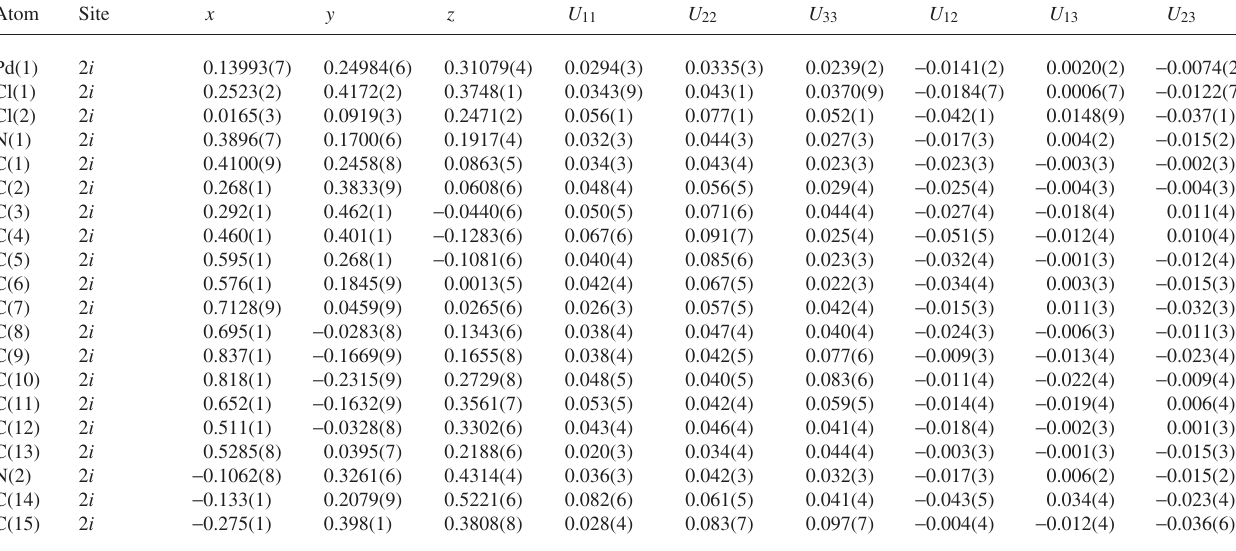
Table 3. Atomic coordinates and displacement parameters (in Å 2 )